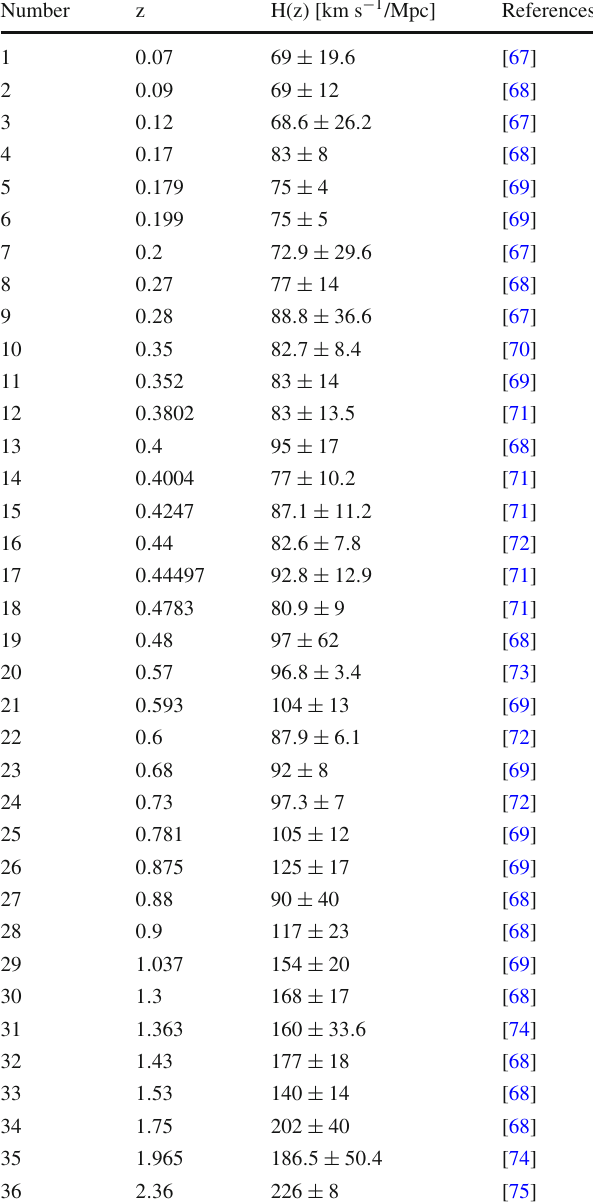
Table 3 The H ( z ) data and their references used in our